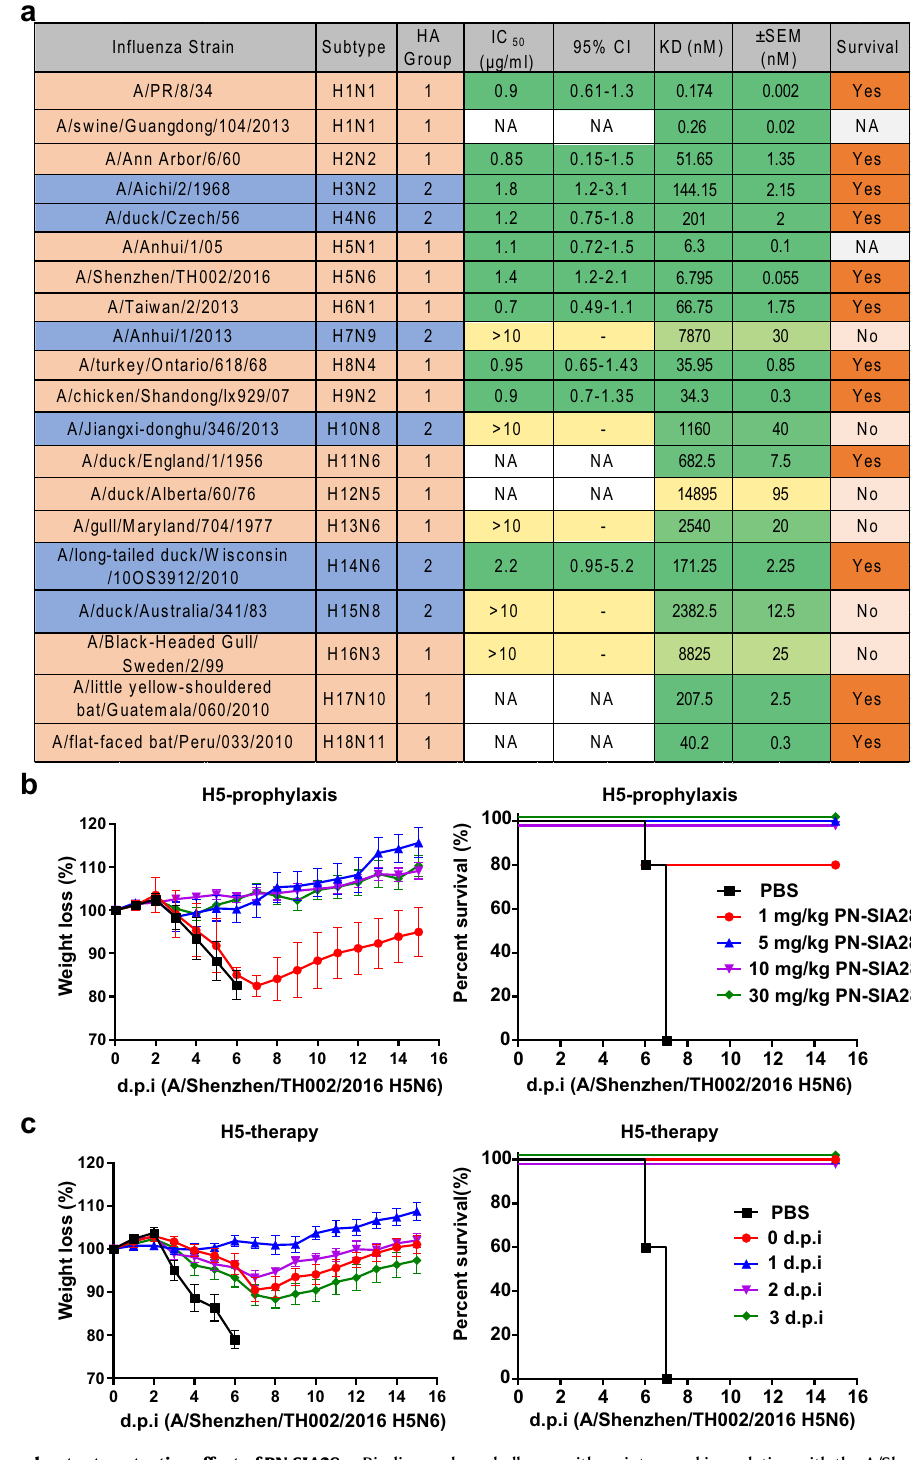
challenge with an intranasal inoculation with the A/Shenzhen/TH002/2016 (H5N6) virus (at day 0). c Therapeutic ef fi cacy of PN-SIA28 against a lethal challenge with theA/Shenzhen/TH002/2016(H5N6)virus.Shownareweightloss(left)andsurvival curves (right) of mice treated with PBS buffer (at day 1) or 15mg/kg of PN-SIA28 right after or 1, 2, or 3 days after lethal challenge by an intranasal inoculation with the A/Shenzhen/TH002/2016 (H5N6) virus (at day 0) are shown. Error bars repre- sent the mean ± s.d. ( n =5). Plots were generated using GraphPad Prism 7. Source data are provided as a Source Data fi